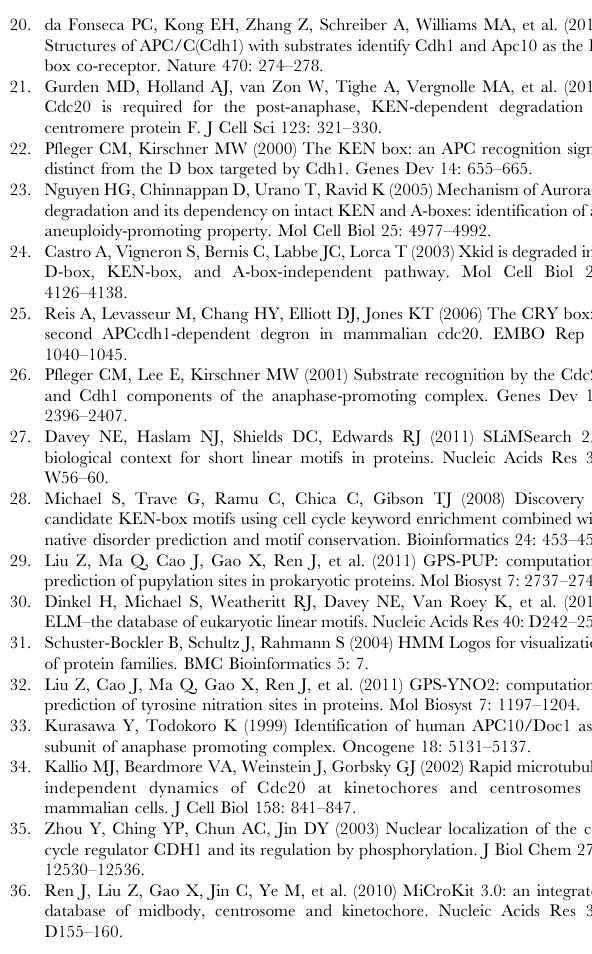
Table S7 Statistical comparison of the GO terms for newly predicted KEN-box and D-box proteins in the human proteome. The proteins in the training data set were excluded. Table S8 From recently published papers, we collected nine D- boxes and KEN-boxes in six proteins. The data set was not used for training. The default parameters were used for the